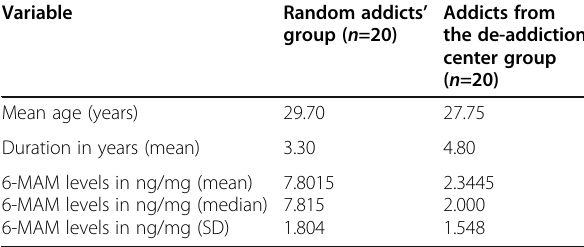
Table 6 Statistics for regular addicts and subjects at de- addiction center